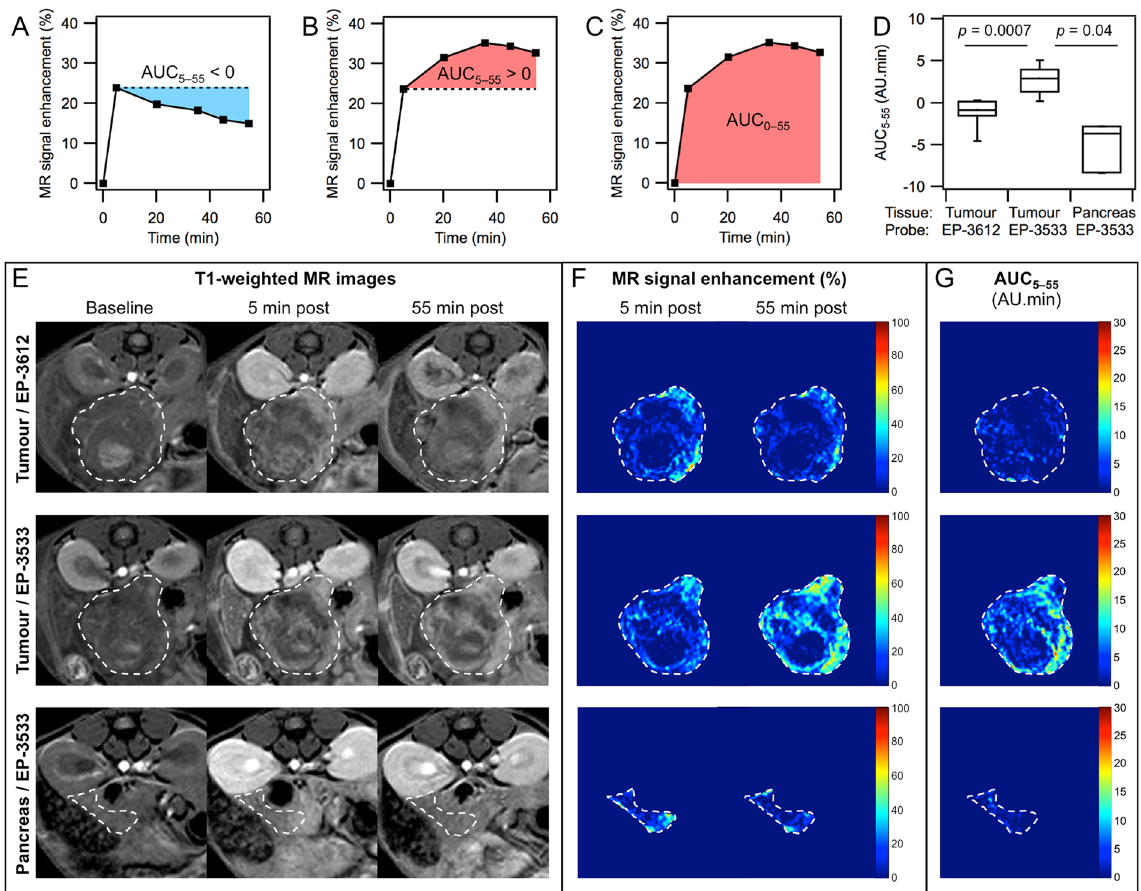
Figure 5. Area under the curve analyses with EP-3533 and EP-3612 enhanced MR. ( A – C ) Time-courses of MR signal enhancement in well-perfused regions of a single tumour showing the methods used to calculate the area under the curve (AUC 5–55 or AUC 0–55 ): ( A ) negative AUC 5–55 (blue) obtained with EP-3612; ( B ) positive AUC 5– 55 (red) obtained with EP-3533 in the same animal as in ( A ); ( C ) AUC 0–55 with EP-3533. ( D ) AUC 5–55 values obtained for tumour with EP-3533 (n = 8), tumour with EP-3612 (n = 7) and healthy pancreas with EP-3533 (n = 3). ( E ) T1-weighted MR images at baseline (left), 5 min post injection (middle) and 55 min post injection (right) of a tumour imaged with EP-3612 (top row) or with EP-3533 (middle row), and for healthy pancreas imaged with EP-3533 (bottom row). The top and middle row are images of the same animal imaged 24 h apart. Bottom row is a sham control animal. Tumour and healthy pancreas are outlined. ( F ) MR signal enhancement maps for the tissue in ( E ) showing sustained enhancement at 55 min post injection with EP-3533 in tumour (middle row), but not with EP-3612 in tumour (top row) or EP-3533 in healthy pancreas (bottom row). ( G ) AUC 5–55 maps generated from the time dependent enhancement for the tissue shown in ( E , F ) indicating large areas of the tumour showing positive AUC 5–55 with EP-3533 (middle) but not with the non-binding probe EP- 3612 (top) or in healthy pancreas with EP-3533